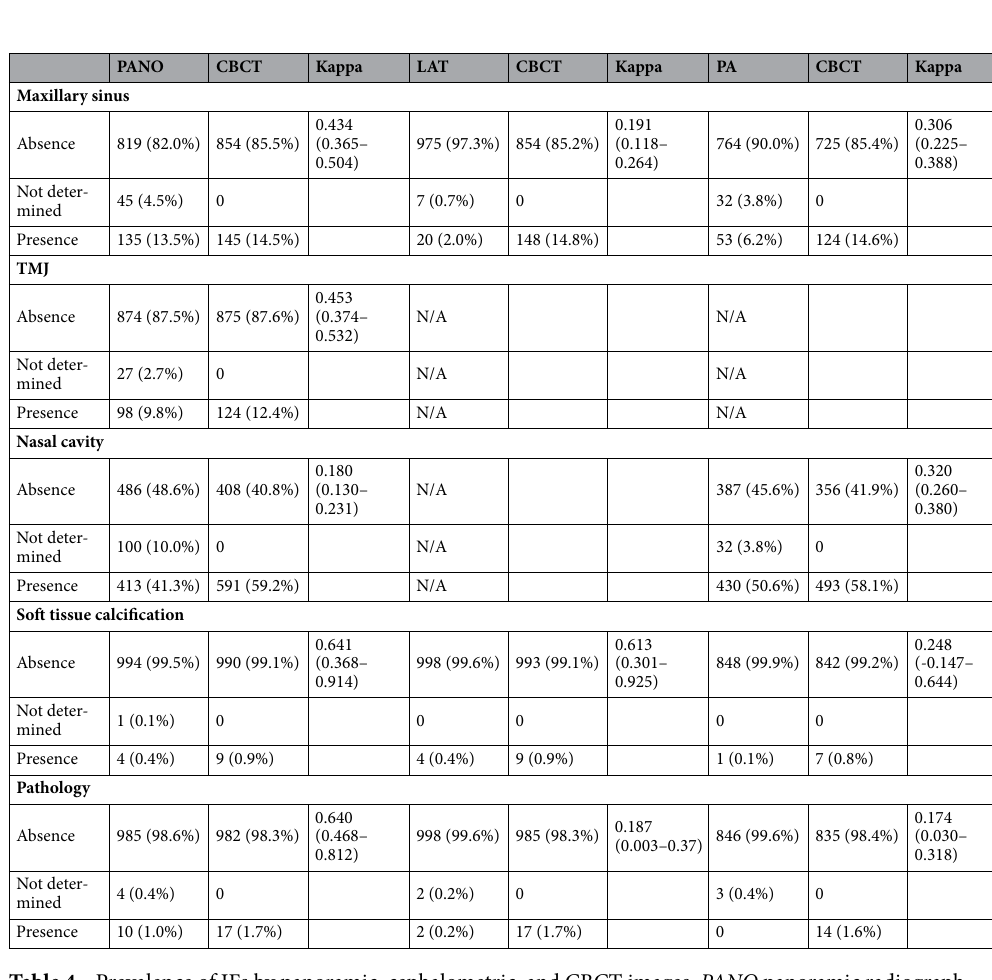
Table 4. Prevalence of IFs by panoramic, cephalometric, and CBCT images. PANO panoramic radiograph, LAT lateral cephalogram, PA postero-anterior